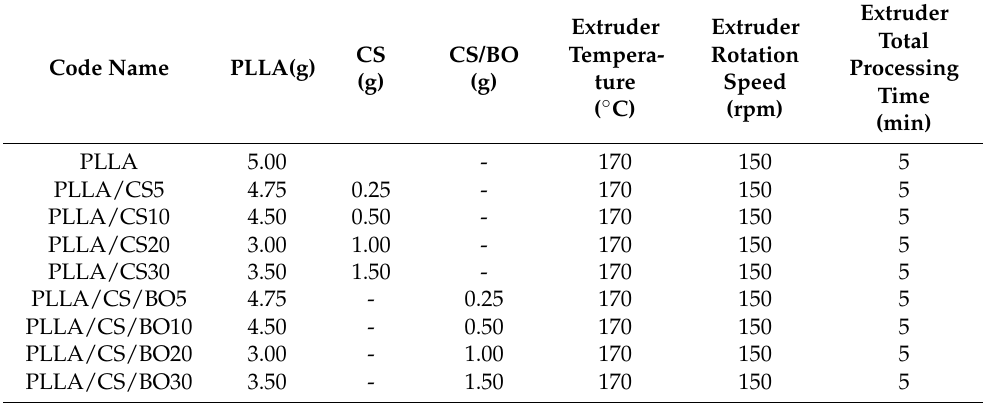
Table 1. Code names, amounts of PLLA and CS/BO used, and extrusion processing conditions for all prepared active